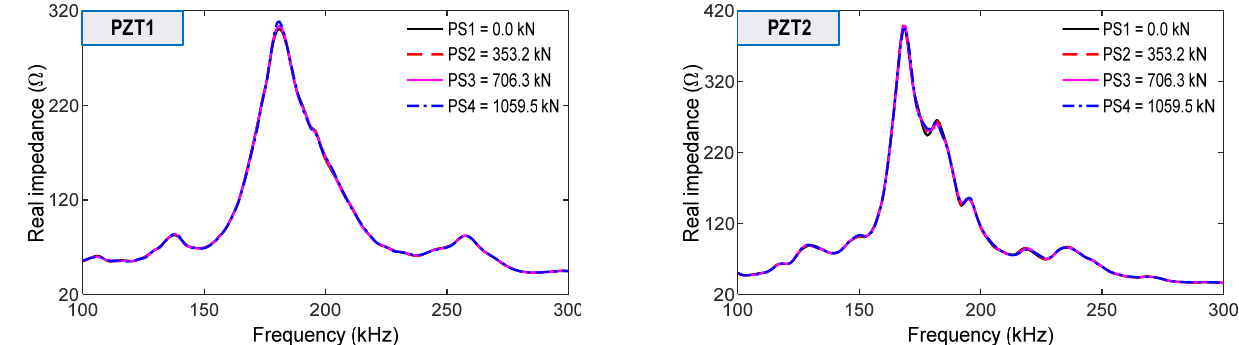
Figure 21. Impedance signatures of surface-mounted PZT sensors for loading cases PS1~PS4.